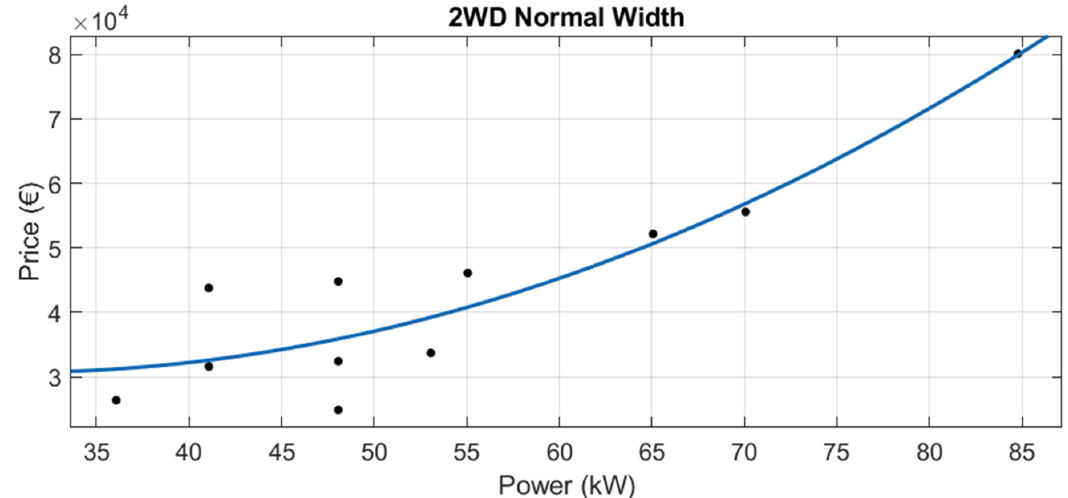
Figure 18. Price vs. power for 2WD normal width new